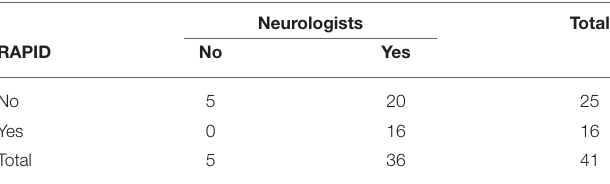
TABLE 7 | Number of infratentorial automated detected DWI lesions in comparison to the visual detected ones by the trained neurologists. Neurologists Total